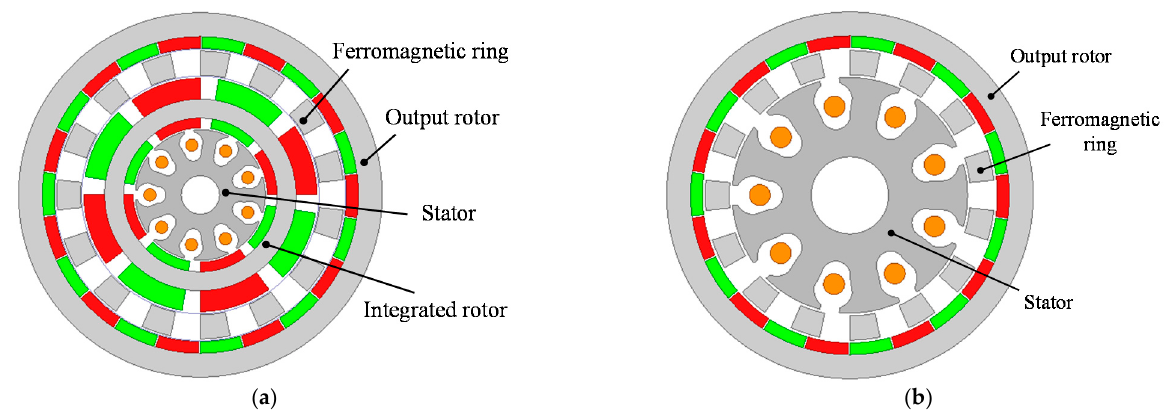
Figure 2. Configurations of the magnetic-geared permanent magnet (MGPM) machines: ( a ) MGPM machine with three air gaps; ( b ) MGPM machine with two air gaps.